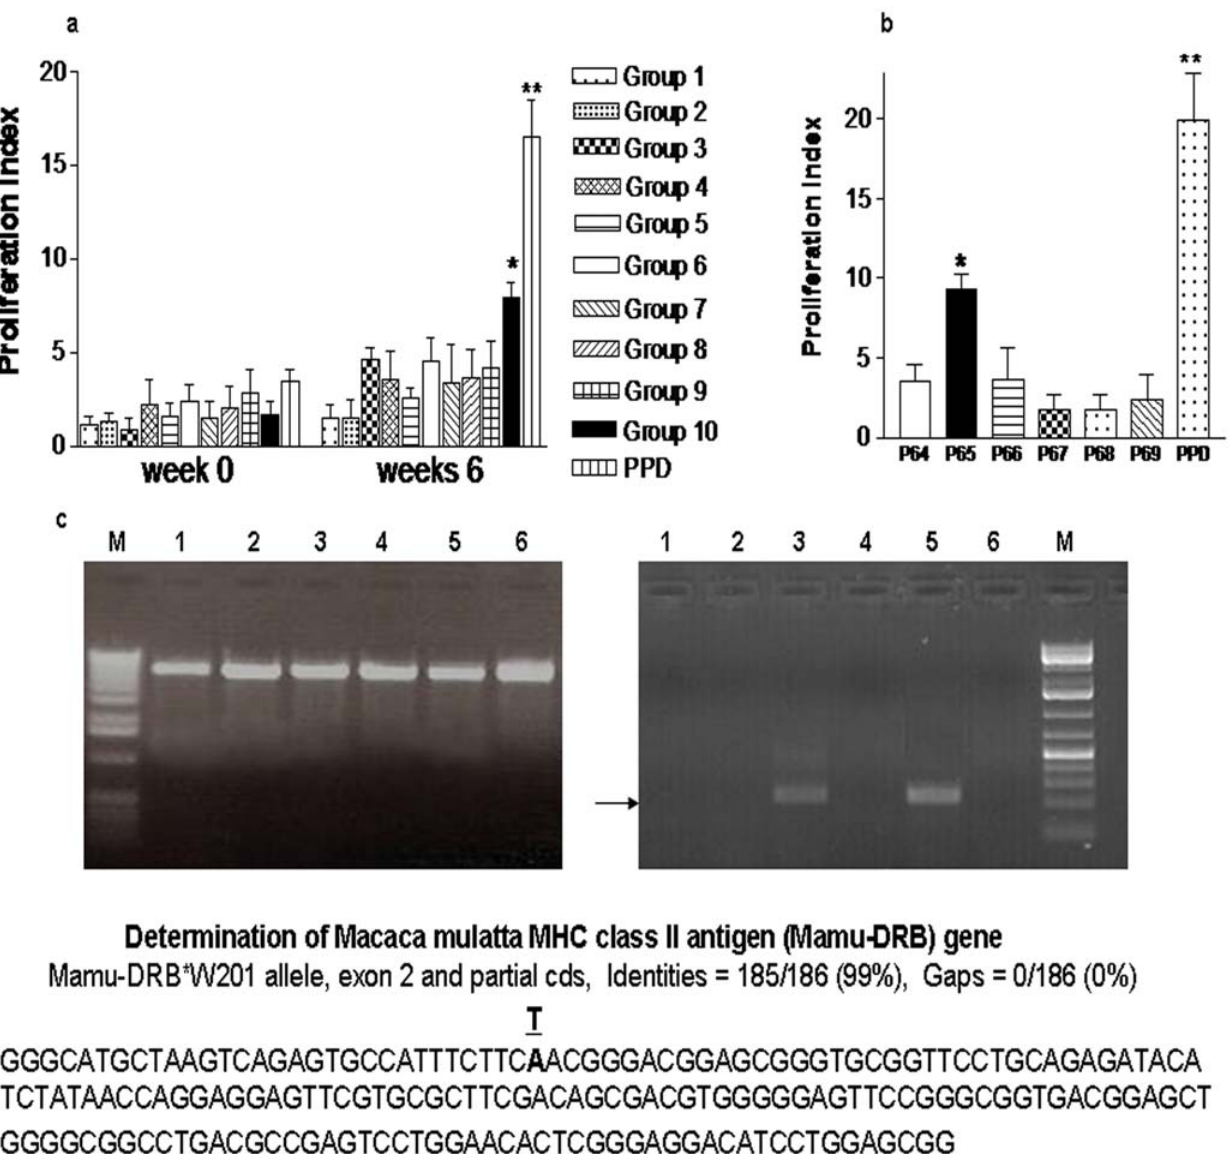
Figure 1. Ag85B peptide 65 induced apparent proliferation in PBL from BCG-vaccinated Mamu-DRB*W201 + macaques. (a) Sixty nine peptides spanning entire Ag85B protein were divided as 10 groups to examine PBL proliferation in the BCG-vaccinated macaques. The proliferation index data indicate that Ag85B Group 10 peptide pool comprised 6 overlapping peptides induced significant PBL proliferation than other peptide groups (*, p , 0.05). Data were mean values derived from PBL of four BCG-vaccinated macaques, with error bars indicating standard errors of means (SEM). (b) PBL from four BCG-vaccinated macaques were further tested for their proliferation to individual peptides in the Group 10 peptide pool, and the proliferation index data reveal that PBL had stronger proliferation to the peptide # 65 (P65) than other peptides (**,p , 0.01; *, p , 0.05). P65 bears the sequence of PNGTHSWEYWGAQLN that corresponds to 258 , 272 amino acid of Ag85B. (c) Nest-PCR were used to amplify full-length Mamu-DRB cDNA (left gel) and, subsequently, the exon 2 (right gel) of b 1 domain in DRB*W201 . As illustrated, each lane represents a sample from one animal; , 250 bp DNA fragments from the lanes 3 and 5 were excised for direct sequencing. The Mamu-DRB*W201 + allele was determined by sequencing alignments through Blast research of GeneBank data base. Representative DNA sequence shows that the nucleotide sequences from a rhesus macaques were identical to the Mamu-DRB*W201 prototype sequence except for one base substitution (T R A).